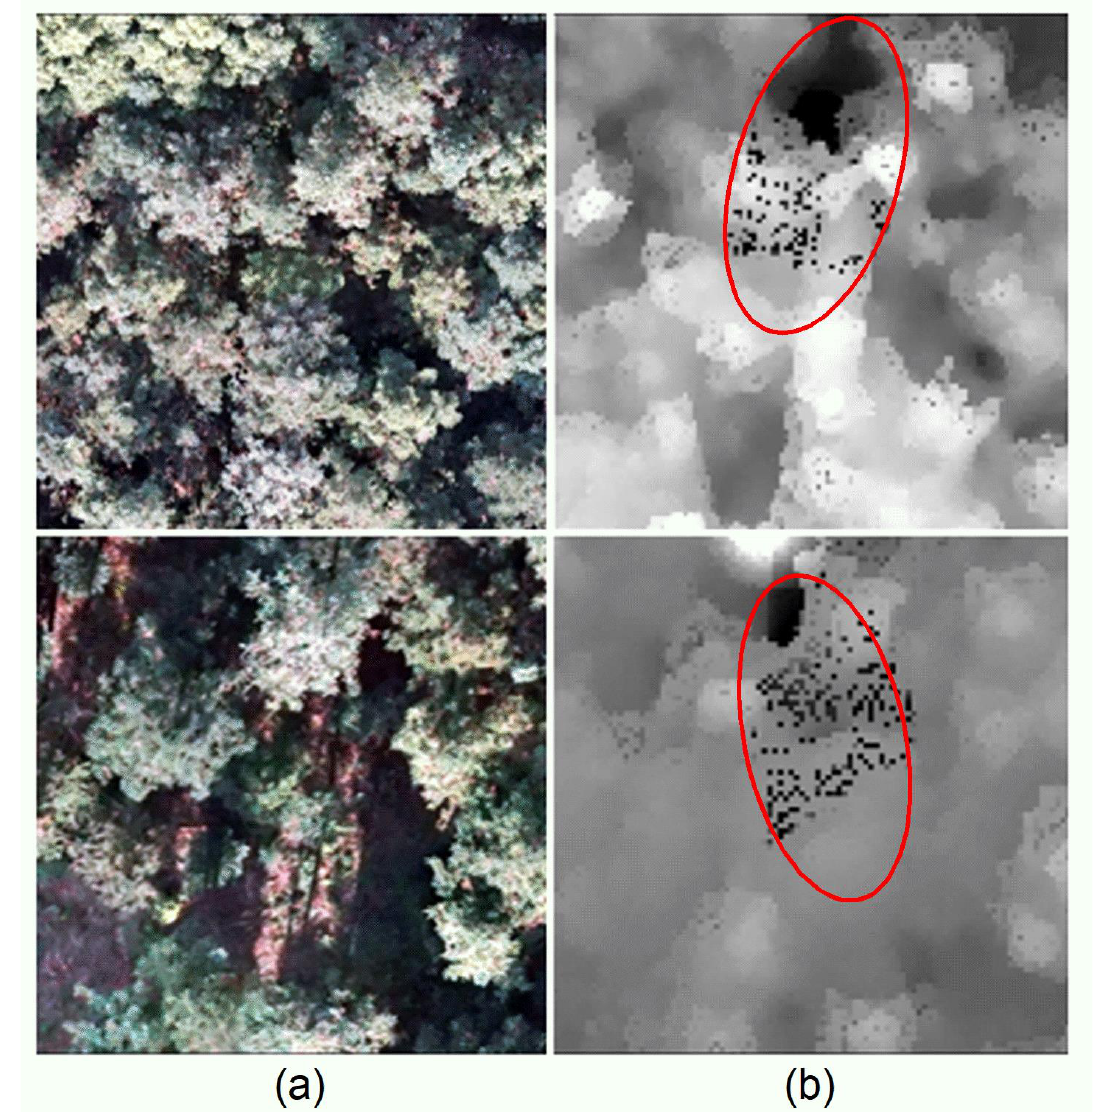
Figure 4. Point-like or spot-like abnormal areas after 3D reconstruction. ( a ) is the DOM data of a sample plots. ( b ) is the DSM data of a sample plots and the red circle is the point or block-like invalid data.